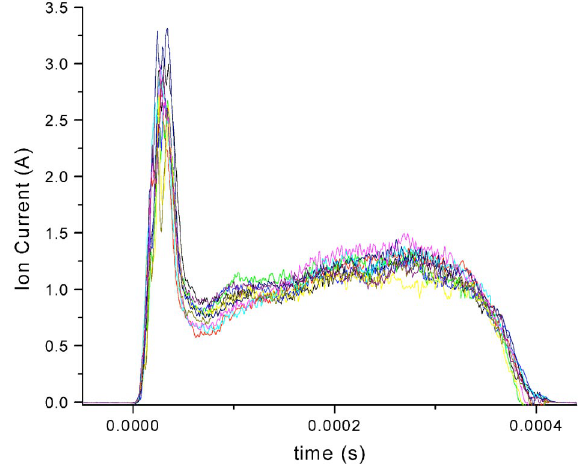
FIG. 26. (Color) Aluminum ion current of ten successive arc pulses collected by an ion collector at the location of the NTX ion beam.